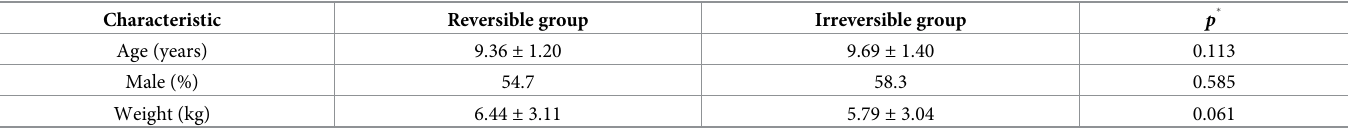
Data of age and weight are given as mean ± standard deviation. Data of male are provided as percentage (%). � Independent